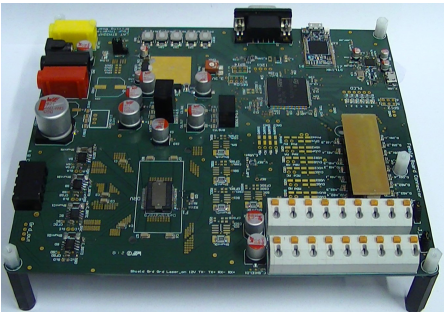
Figure 16. Motherboard used to drive the physical plant in the experiments.